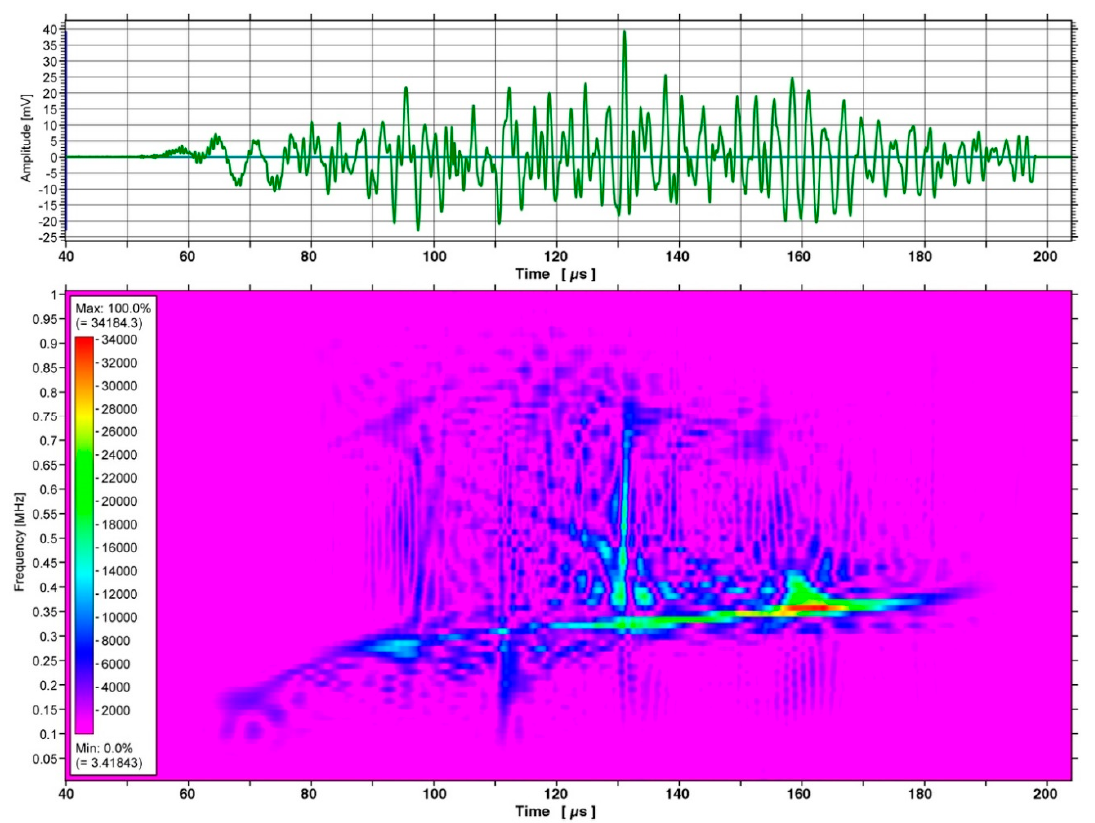
Figure A4. Output waveform of a KRN sensor without FET buffer (#12035) from symmetric excitation method and its CWT spectrogram for 40–200 µs segment up to 1 MHz. Notice much lower intensities below 100 kHz in comparison to Figure 6.